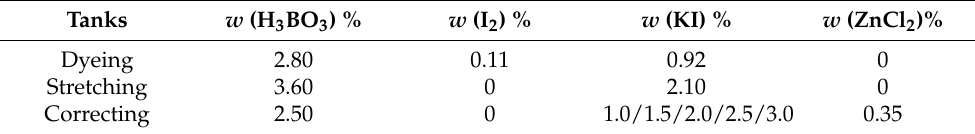
Figure 1. Preparation process of PVA polarizing film. Table 1. Concentration of the solution in each tank for preparing PVA polarizing film.